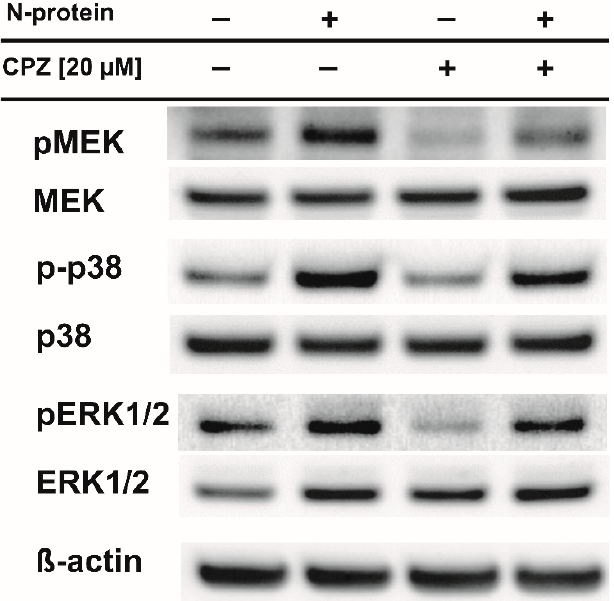
Figure 6. Chlorpromazine impairs cellular signaling via MEK/ERK in human monocytes induced by the nucleocapsid of SARS-CoV-2. Human monocytes and those pretreated with chlorpromazine (20 μ M, 3 h) were treated with the SARS-CoV-2 nucleocapsid for 1 h (1 μ g/mL). After that time, protein lysates were prepared and analyzed by Western blotting.